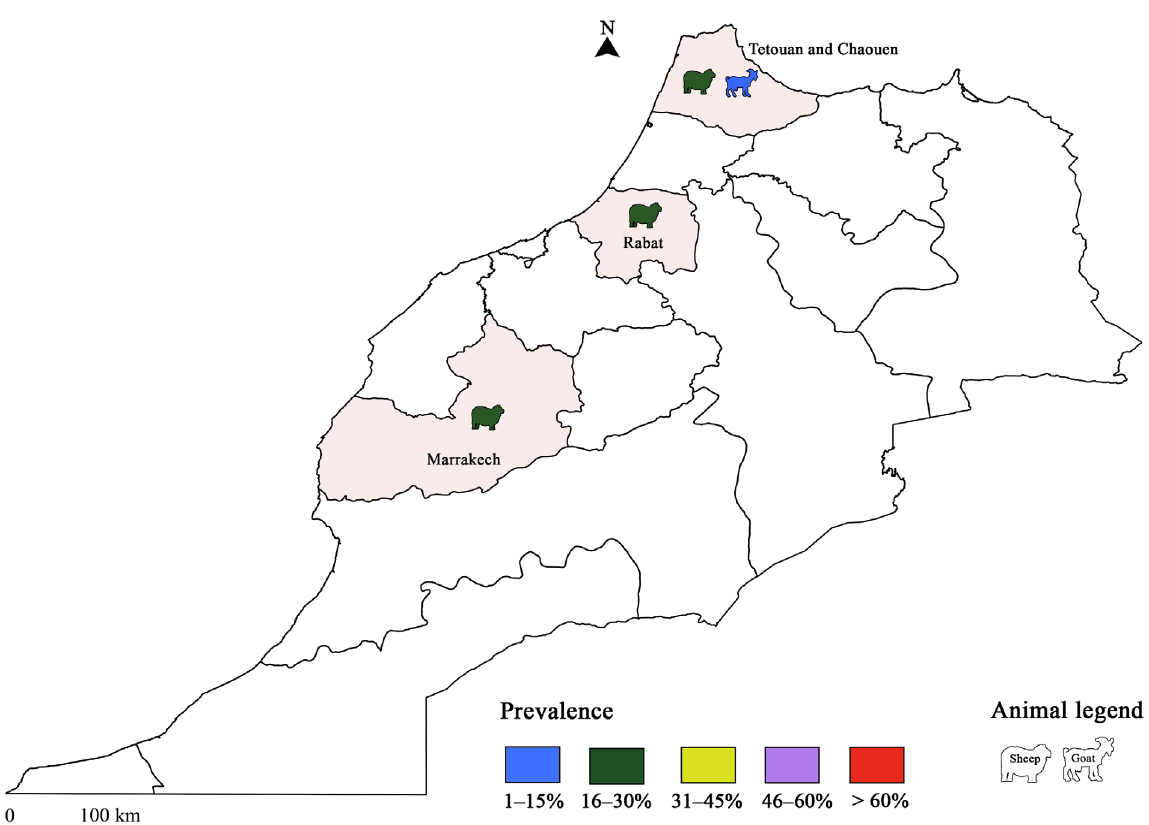
Figure 1. Prevalence of Toxoplasma gondii infection in Morocco: Animal toxoplasmosis,